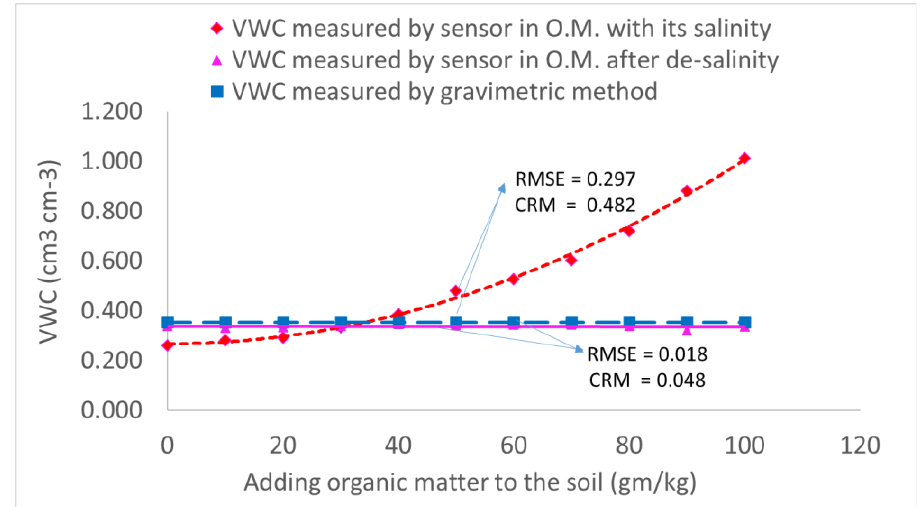
Figure 6. Influence of organic matter on sensor measurements before and after desalination.